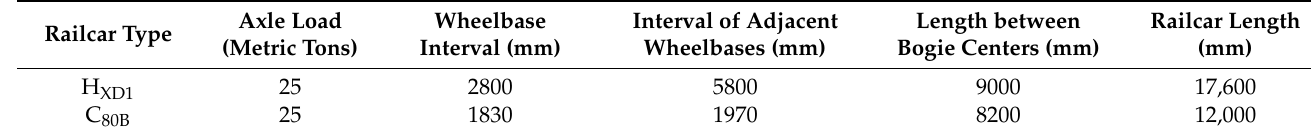
Table 1. Configuration parameters of typical railcars operated in the D railway.